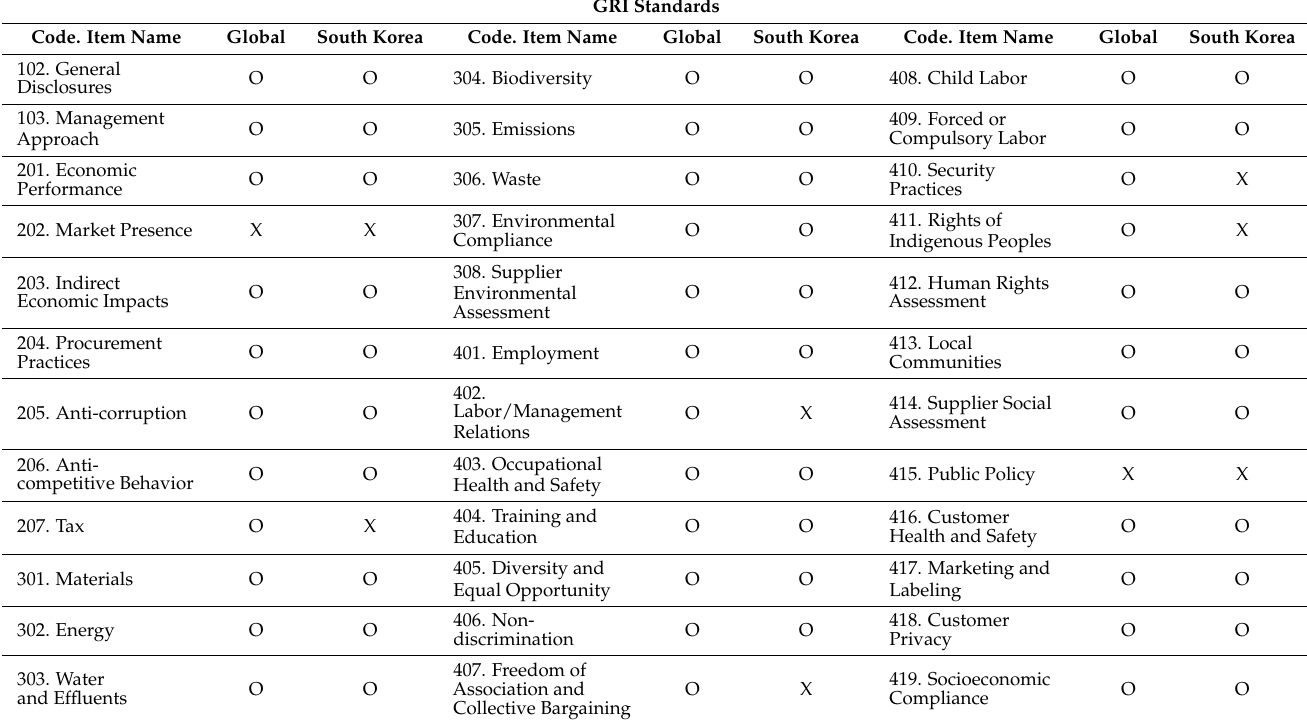
Table 8. ESG sustainability issues of construction companies through GRI